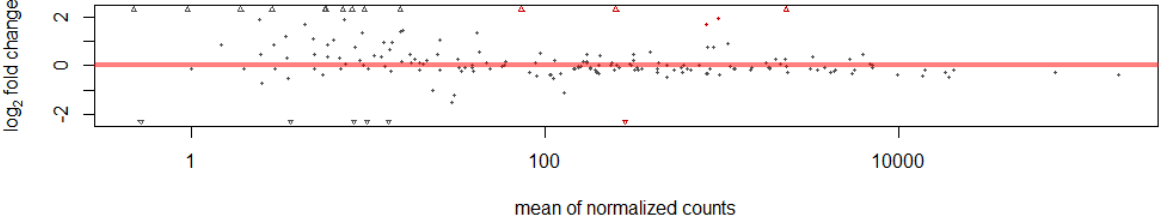
Figure 2. Plot of normalized mean versus log2-fold change for the miRNAs in black and white hair follicles. The red colour marks genes detected as differentially expressed. The red points and triangle below and above the red line indicate downregulation and upregulation, respectively in black hair follicles, and the reverse in white hair follicles. The symbols at the upper and lower plot border (the red and dark triangle) indicate genes with very large or infinite log fold change.